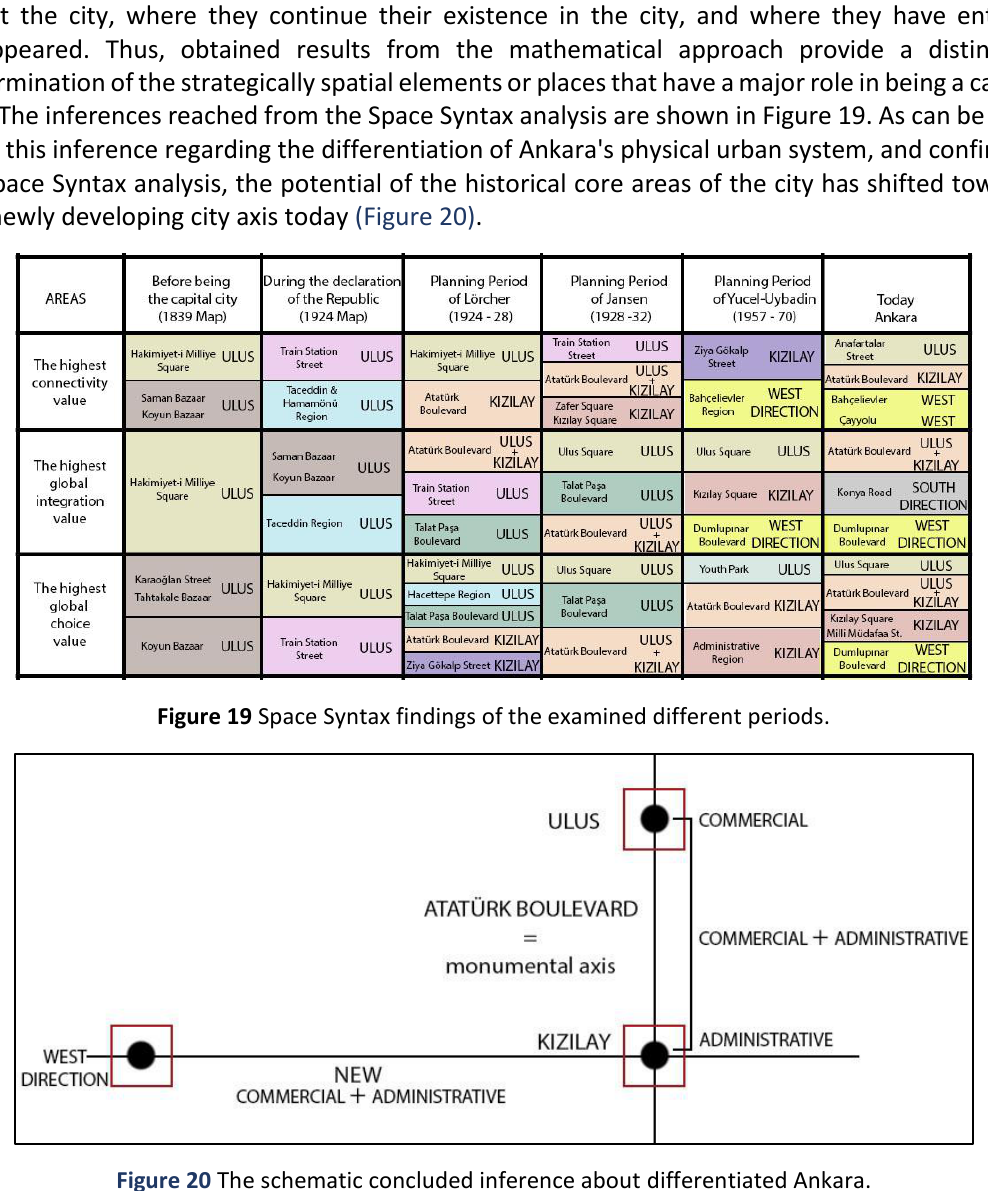
Figure 20 The schematic concluded inference about differentiated